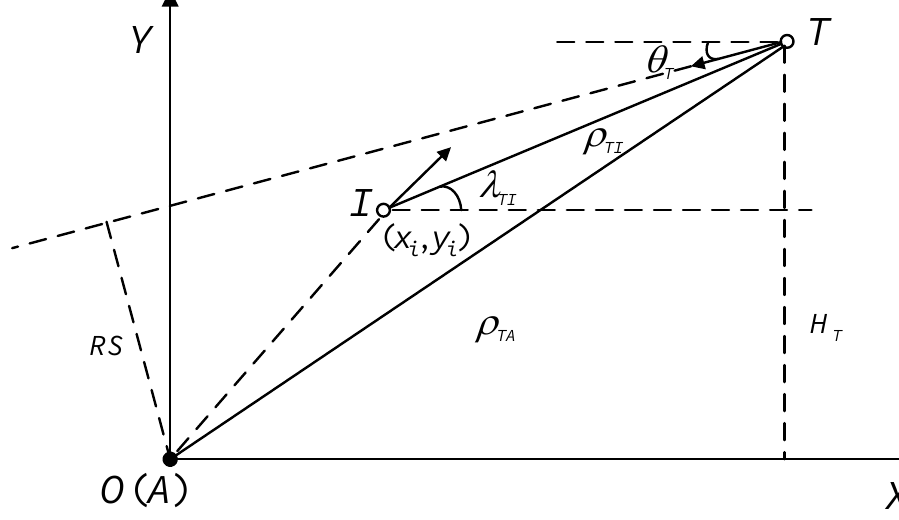
Figure 2. The planar geometry of the interceptor, target and defending asset.